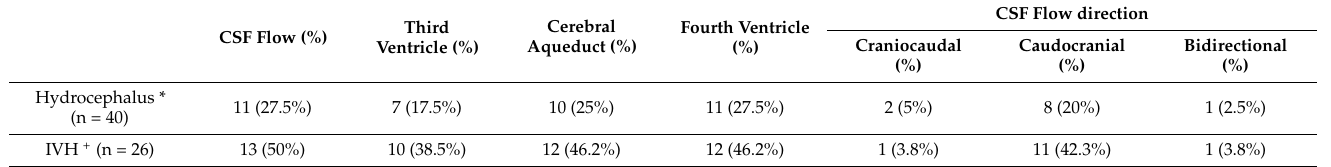
Table 1. Identification of CSF flow in infants using MVI